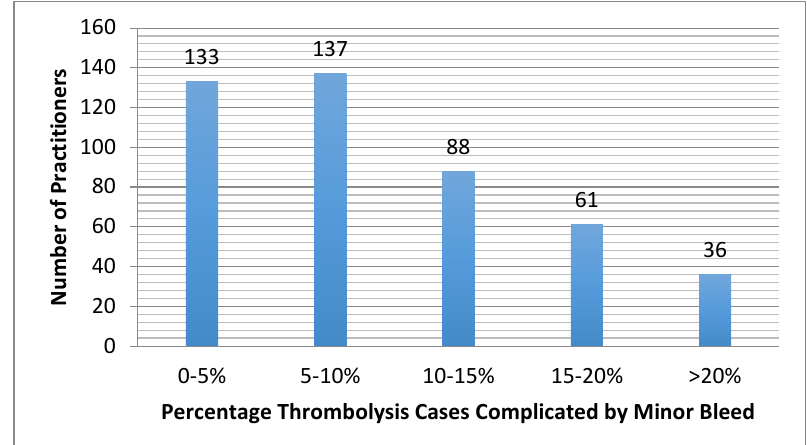
Figure 5. Self-reported percentages of cases that are complicated by minor bleeding, such as oozing at the access site or blood in stool without a significant drop in hematocrit.